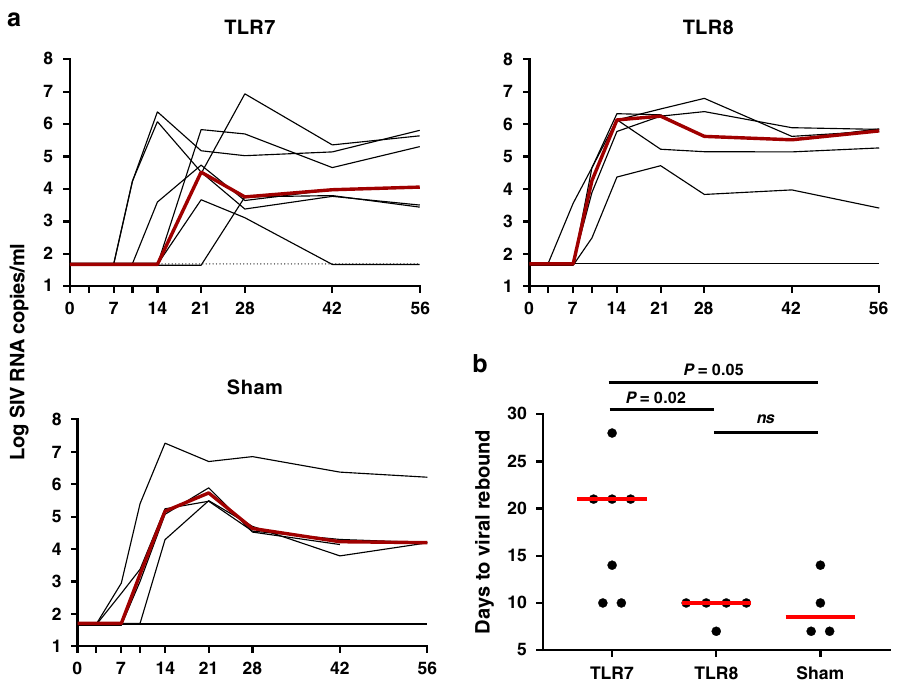
Fig. 2 Plasma SIV RNA following after ART discontinuation. a Plasma viral RNA (log copies/ml) is shown for days 0 – 56 following ART discontinuation for the TLR7 agonist ( n = 7), TLR8 agonist ( n = 5), and sham groups ( n = 4). b Days to viral rebound de fi ned as the fi rst detectable plasma SIV RNA in each animal. Red horizontal bars indicate median values. P values calculated using two-sided Mann – Whitney